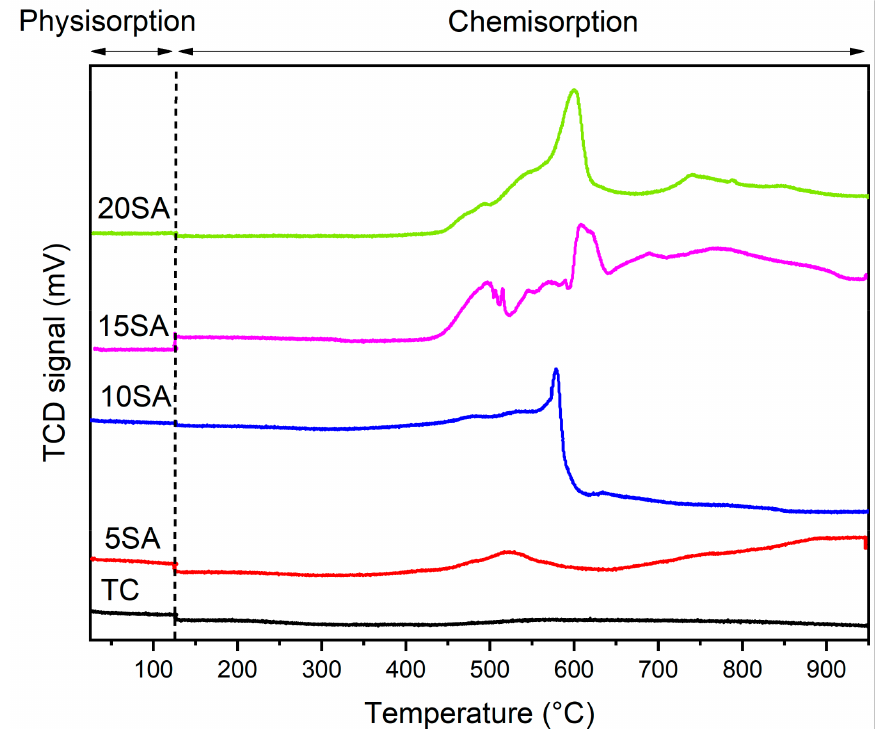
Figure 5. NH 3 -TPD profile of non-sulphated and sulphated-titania catalyst at various concentration. SEM-EDX analysis was used to study the surface morphology and elemental